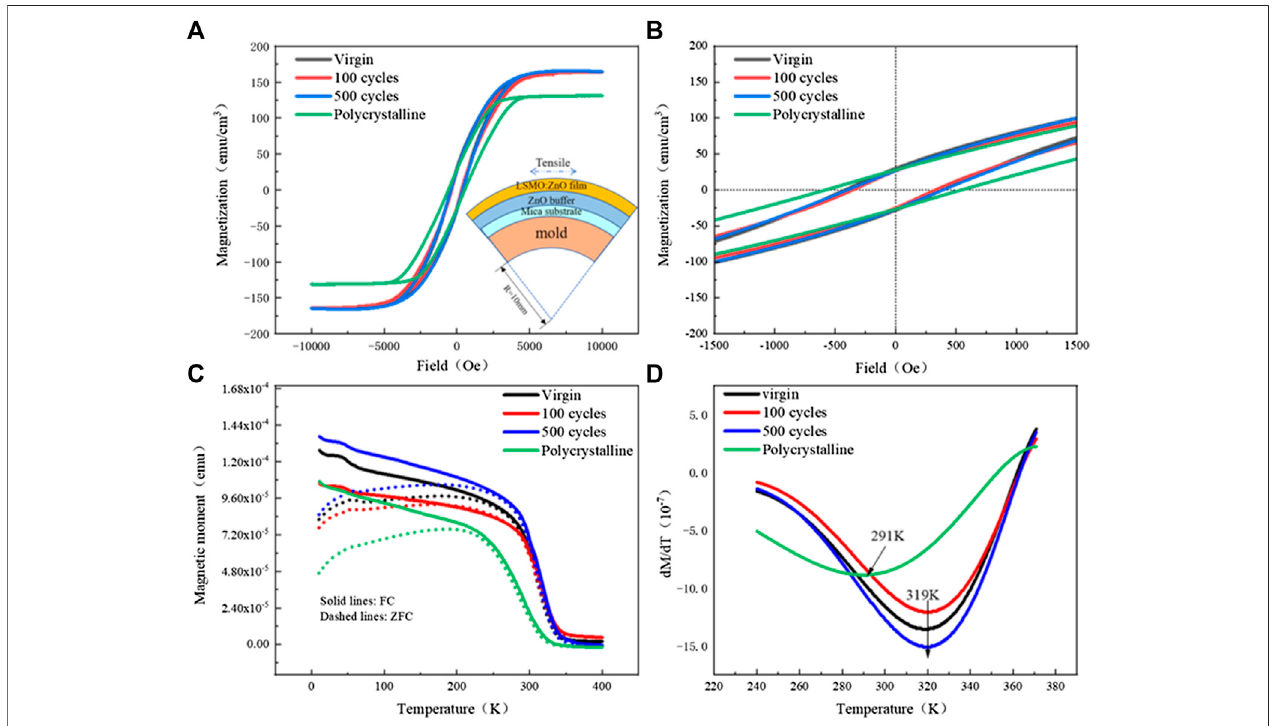
FIGURE 3 | Magnetic properties of the LSMO:ZnO thin fi lms on mica. (A) M-H curves measured at 10 K and (B) enlarged area to show the coercivity; (C) FC and ZFC M-T curves and (D) dM/dT versus temperature under a 1T fi eld.